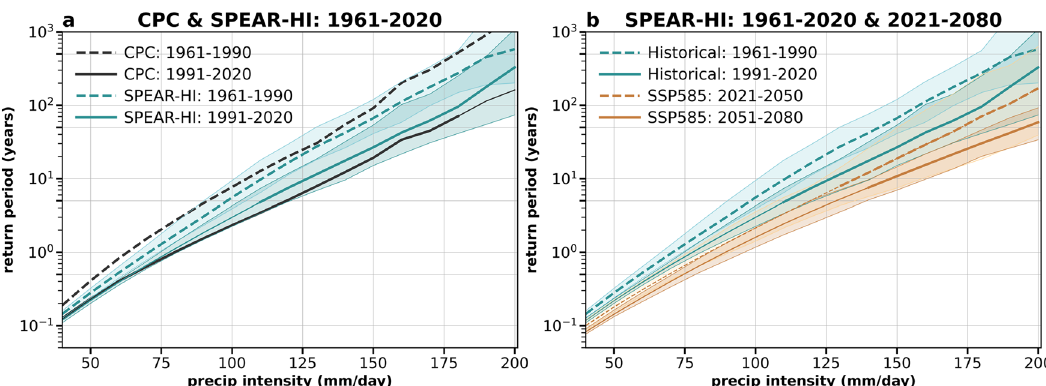
Fig. 3 Return periods of extreme precipitation events using different thresholds as seen in the observations and SPEAR_HI. a Compare the return periods in 1961 – 1990 (dashed lines) and 1991 – 2020 (solid lines). The observations and SPEAR_HI ensemble mean are shown in black and green lines, respectively. b Compare the return periods in the SPEAR_HI historical (green lines) and SSP5-8.5 (orange lines) simulations between 2021 and 2080 versus 1961 and 2020. Shaded area encompasses the spread of the SPEAR_HI ensemble. Thick solid lines indicate the changes compared with the earlier 30-year period are statistically signi fi cant at 95% con fi dence interval using the bootstrapping method. The y -coordinate is shown in a logarithmic scale and is in the unit of